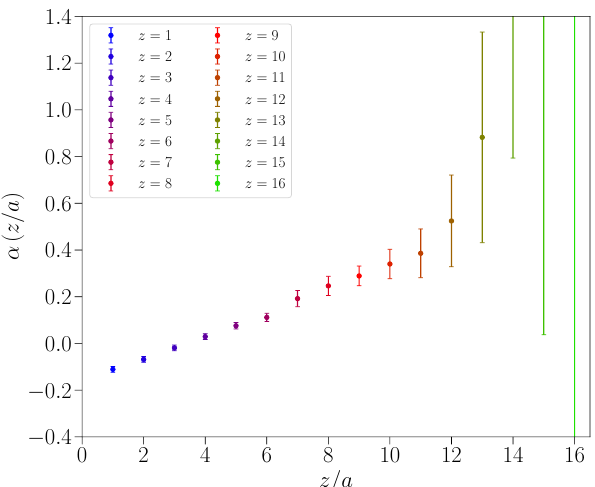
Figure 21. The fitted value of α as a function of z/a resulting from the cosine-transform of the model pseudo-PDF in eq. (5.1) fit to Re M (cid:0) ν, z 2 (cid:1) . The decrease of α with z/a is in agreement with expectations from the Altarelli-Parisi evolution of the pseudo-PDF. This dependence is however clearly